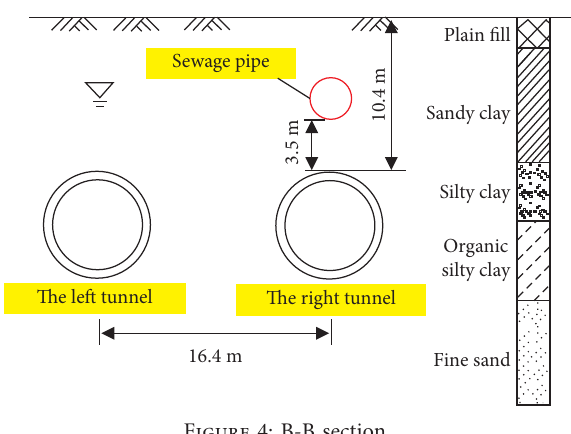
Figure 4: B-B section. model size was 70 m ( X direction) × 40 m ( Y direction) × 75 m ( Z direction), and the sewage pipe was parallel to the tunnel. The positional relationship of the tubes is shown in Figure 5. The side is limited to the horizontal displacement and the corner, the bottom surface is fully fixed, and the top surface is freely constrained. The surface of the groundwater level line is set as the seepage boundary. The pore water pressure is zero, and the side and bottom surfaces are